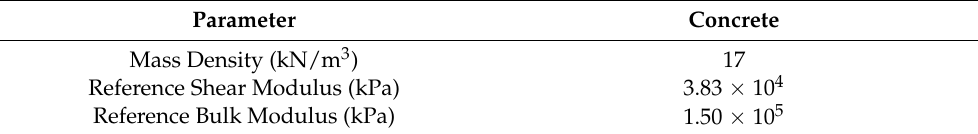
Table 2. Infill soil